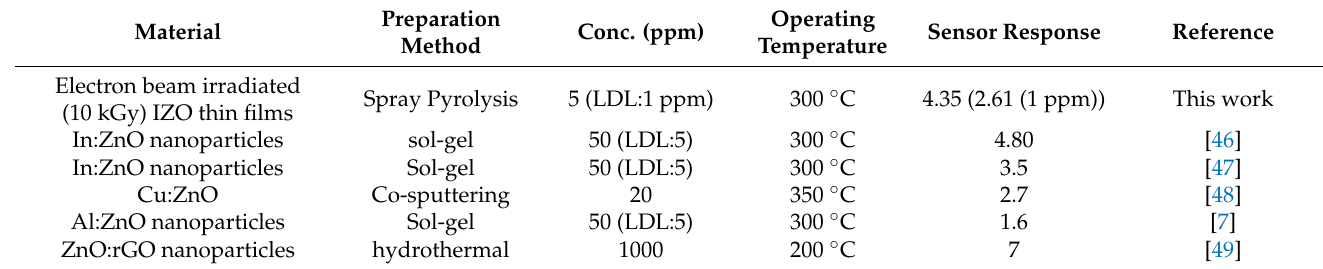
Table 4. Comparison study.